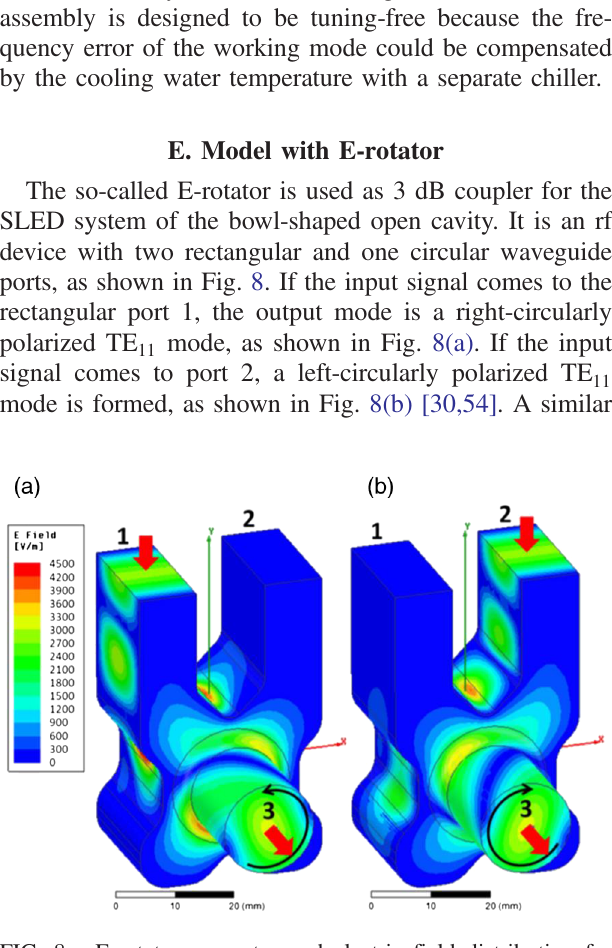
FIG. 8. E-rotator geometry and electric field distribution for 1 Wof input power into port 1 (a) and port 2 (b). The polarization of the circular TE 11 mode in the output port is indicated using black arrows